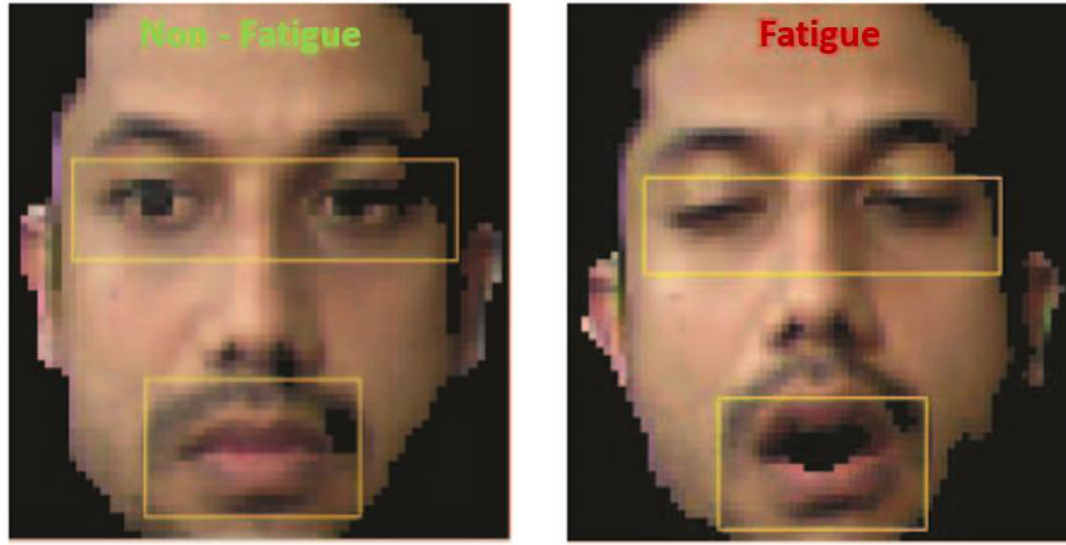
Figure 4. Face areas identified by the software for an avatar (eyes and